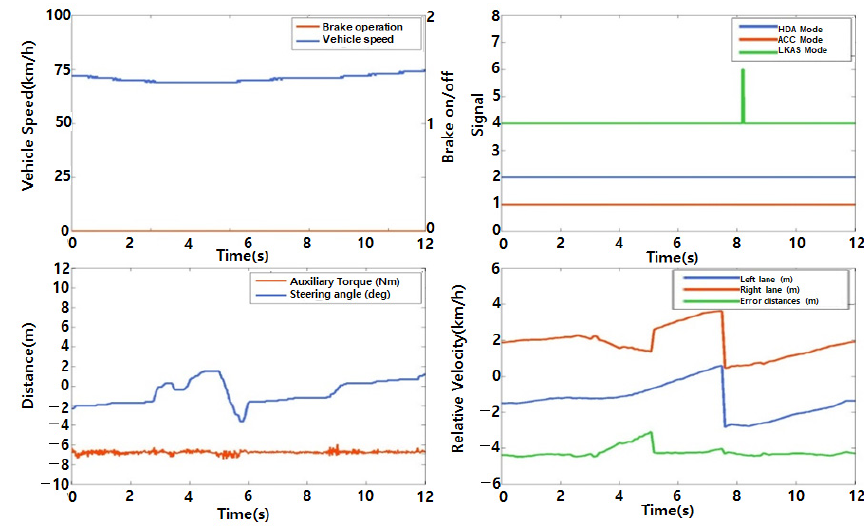
Figure 9. Preliminary data analysis for case 6.